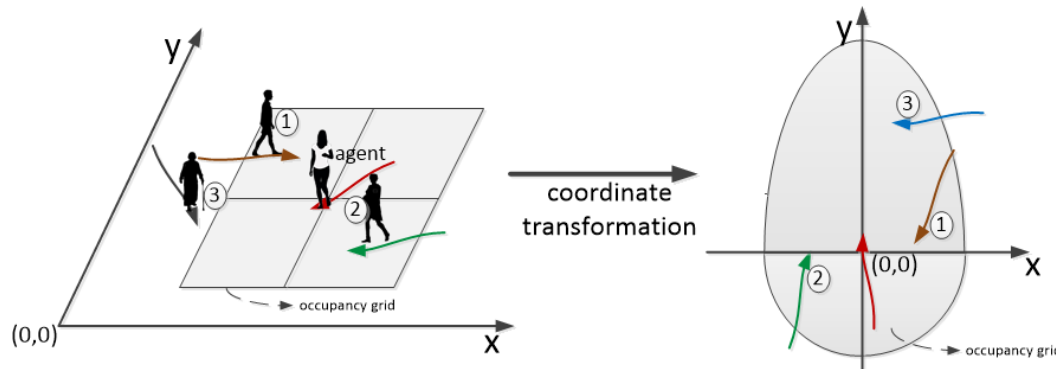
Figure 5. Coordinate transformation and neighborhood definition: ( left ) absolute coordinates and rectangular grid map in absolute coordinates; ( right ) relative coordinates and anisotropic neighborhood map. After a coordinate transformation, the neighbors are re-described with relative motion: relative velocity (cid:101) v i , j and relative position (cid:101) p i , j t t